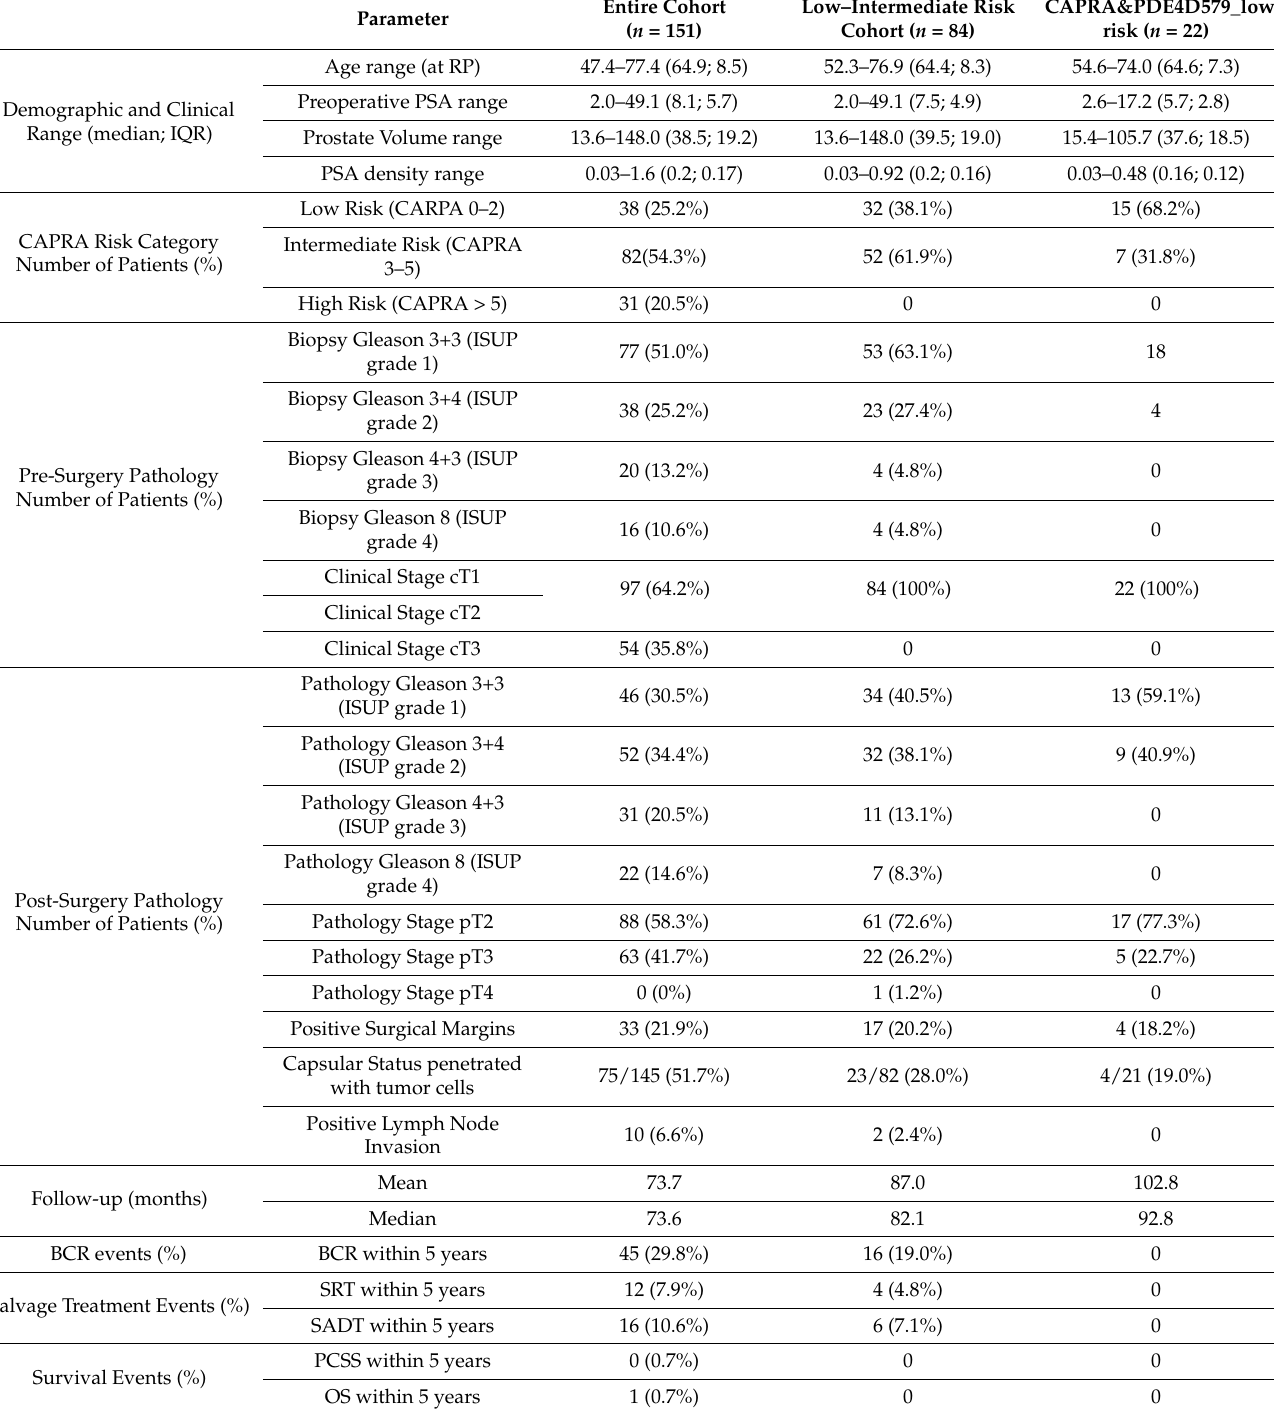
Table 1. The patient demographics for the entire patient cohort ( n = 151), as well as the selected low- to-intermediate-risk cohort, and the low-risk patient group according to the CAPRA&PDE4D5/7/9_ BCR score is provided. IQR—interquartile range; RP—radical prostatectomy; ISUP grade—ISUP Gleason grade group; BCR—biochemical recurrence; SRT—salvage radiation therapy; SADT—salvage androgen deprivation therapy; PCSS—prostate cancer specific survival; OS—overall